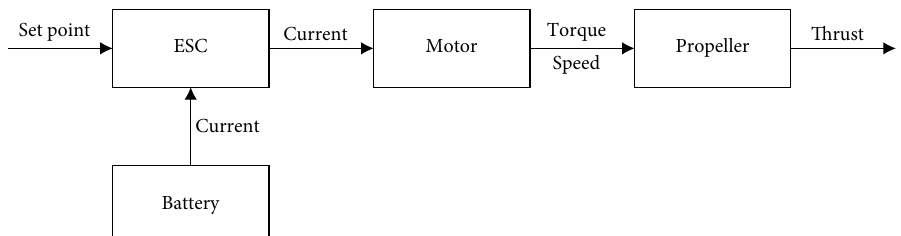
Figure 2: Multirotor propulsion chain